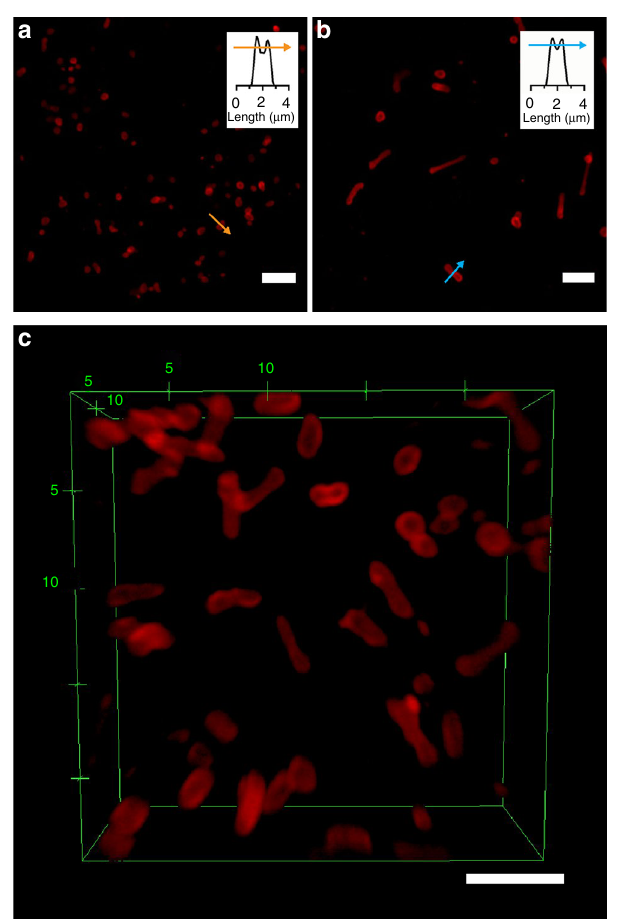
Fig. 4 Confocal laser scanning microscopy (CLSM) images of a giant ellipsoidal polymersomes (GE) and b tubular polymersomes (TU) embedded in 1.5% w/v agarose gel. c Z -stack image of tubular polymersomes (TU). Insets in a , b show fl uorescence intensity plot pro fi les highlighting the membrane structure and GE and TU, respectively.